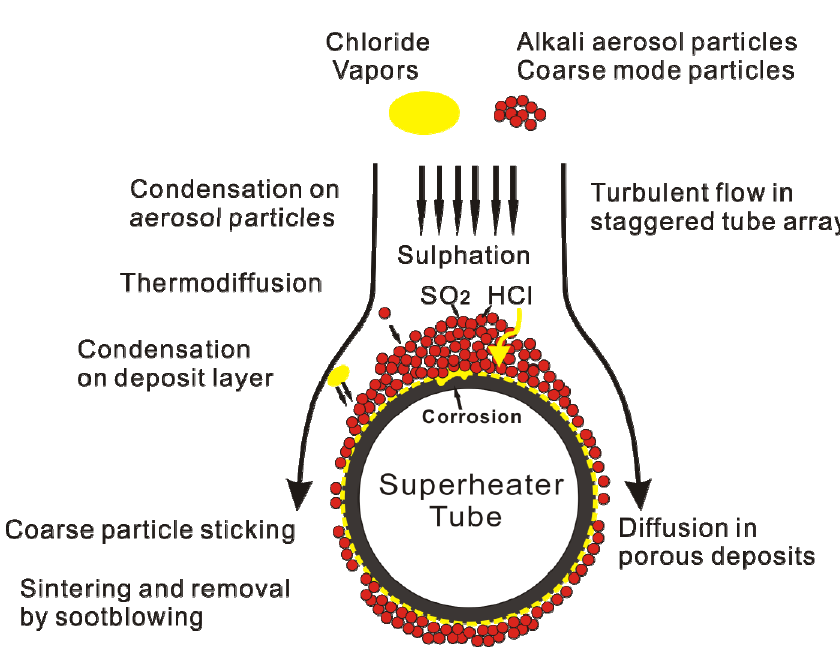
Figure 4. Schematic of mechanisms of ash formation and deposition on a superheater tube surface